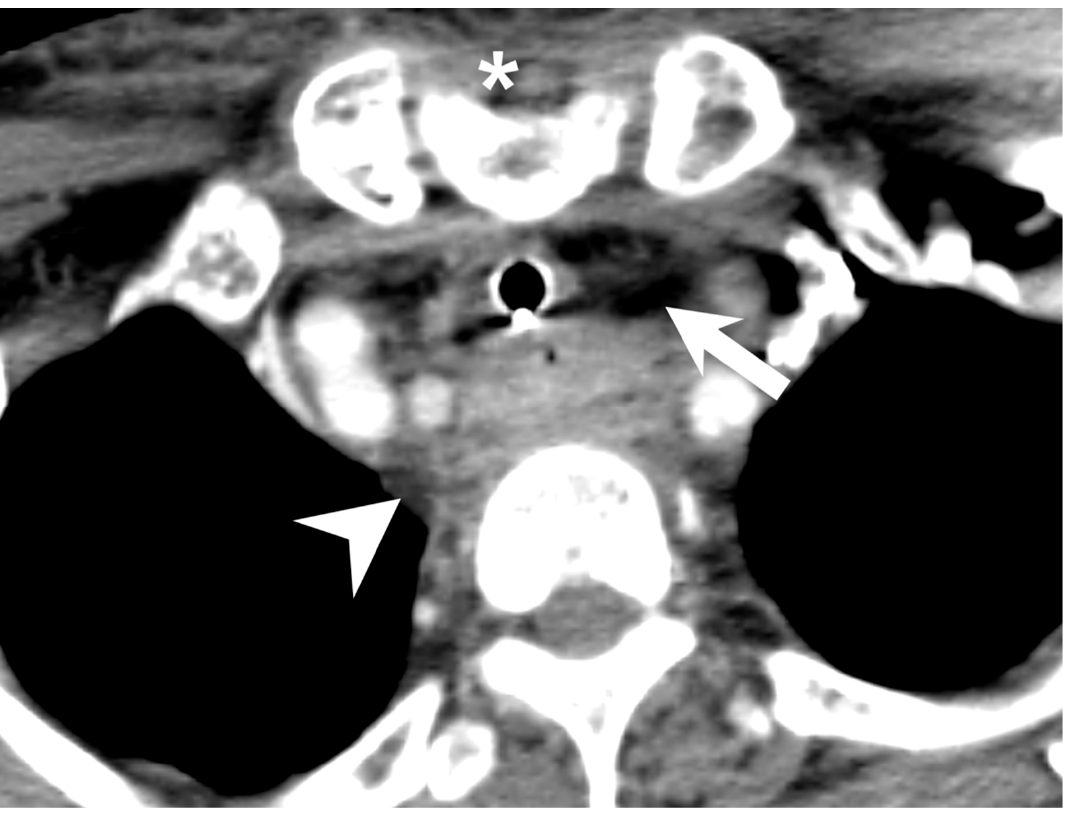
Figure 1. A patient with deep neck infection and mediastinitis with conduction of tracheostomy; micro-abscess (arrowhead) and gas (arrow) formation was noted. Sternum notch (asterisk).